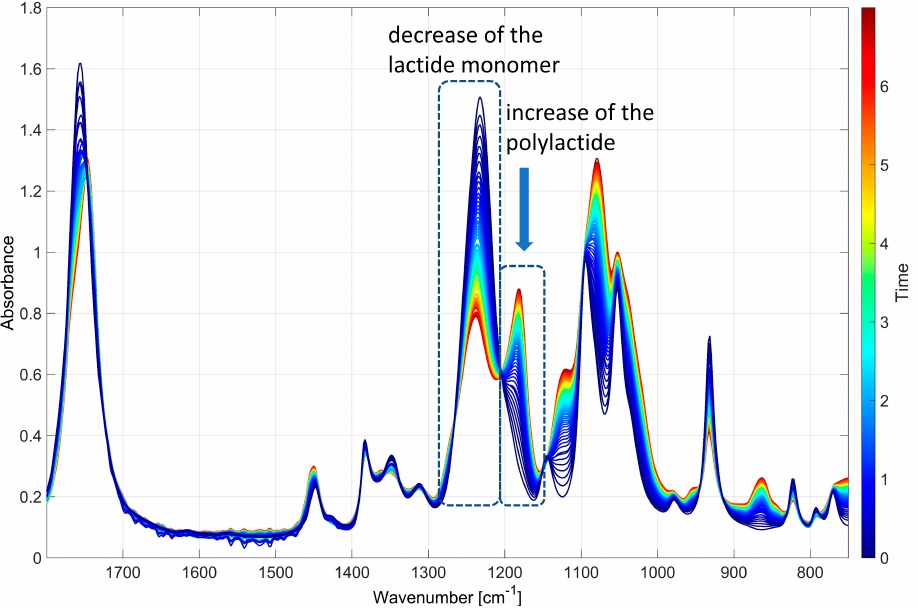
Figure 4. 2D time-resolved FT-IR spectra of the polymerization method c rac -lactide with C2